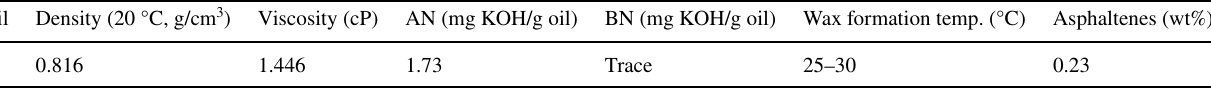
Table 2 Properties of oil A (Standnes and Austad 2000)